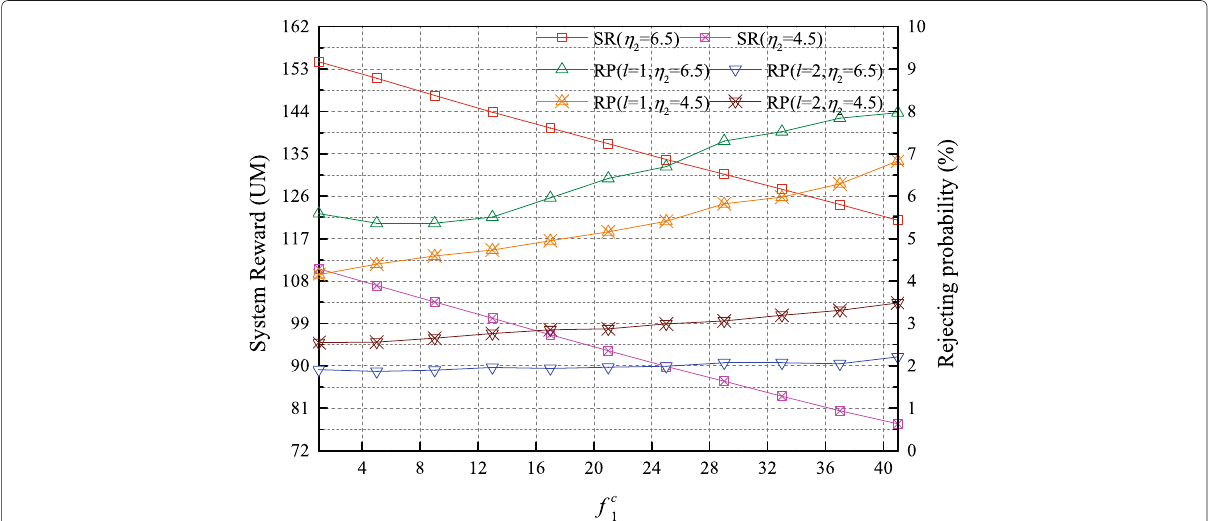
(cid:3) (cid:2) of occupying the dynamically extended computing f c 1